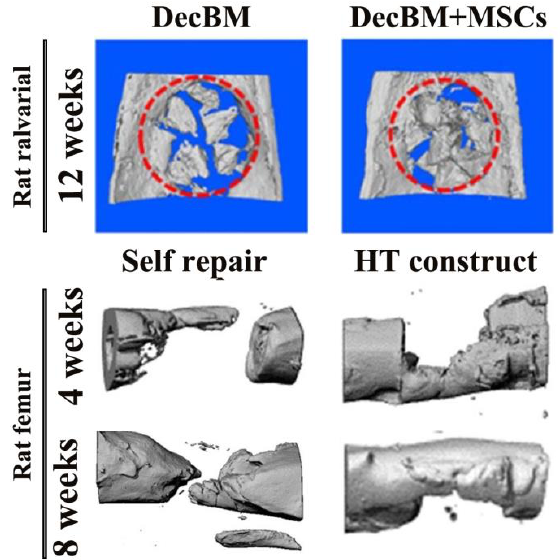
Figure 2. Repair and reconstruction of different natural bone grafts implanted in different sites in rat bone defect model. DecBM, decellularized bone matrix. RecBM, recellularized bone matrix. HT, hypertrophic cartilage tissues. Self repair, defect repair without any scaffold. MSCs, mesenchymal stem cells. Reproduced with permission from [58]. Copyright Lee et al., 2016. Reproduced with permission from [71]. Copyright Elsevier B.V., 2015.